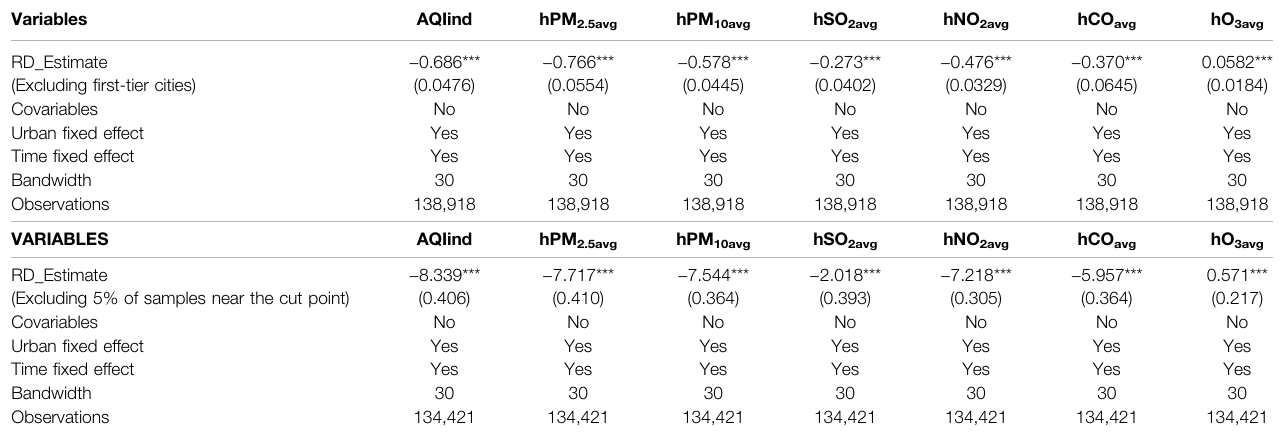
TABLE 7 | “ Donut hole ” test results.